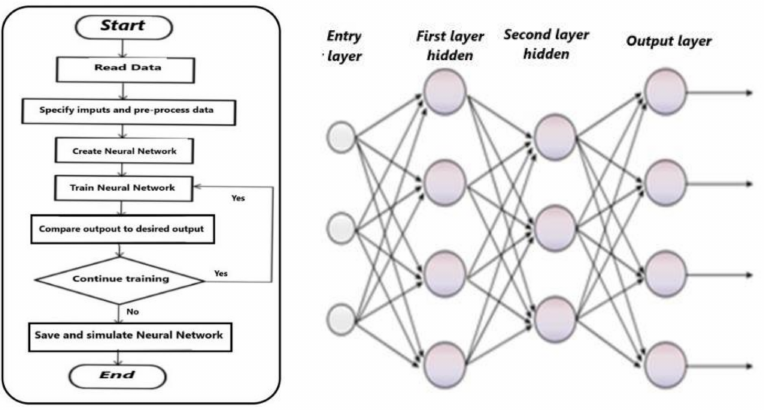
Figure 9. Flowchart of the proposed multi-layer perceptron (MLP) ( left ) and its internal structure ( right